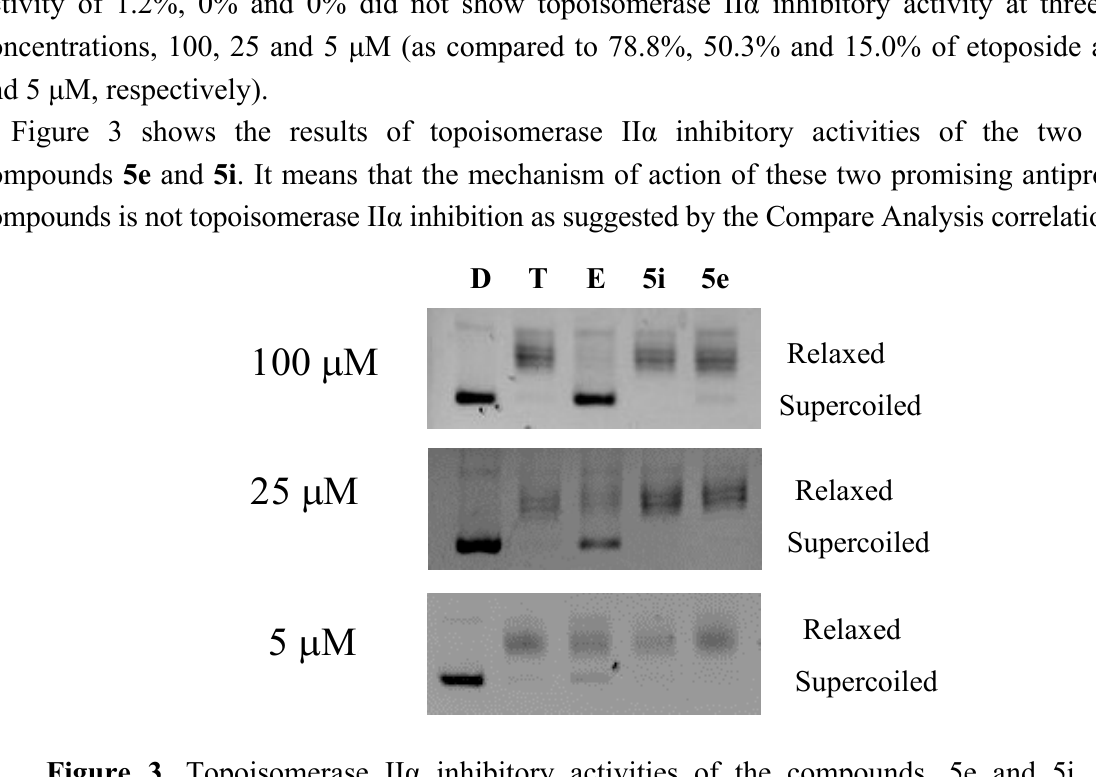
Figure 3. Topoisomerase IIα inhibitory activities of the compounds, 5e and 5i. The compounds were examined in a final concentration of 5, 25 and 100 µM, respectively, as designated. Lane D: pBR322 only, Lane T: pBR322 + topoisomerase IIα, Lane E: pBR322 + topoisomerase IIα + etoposide, Lane 5e: pBR322 + topoisomerase IIα + compound 5e in designated concentrations, Lane 5i: pBR322 + topoisomerase IIα + compound 5i in designated